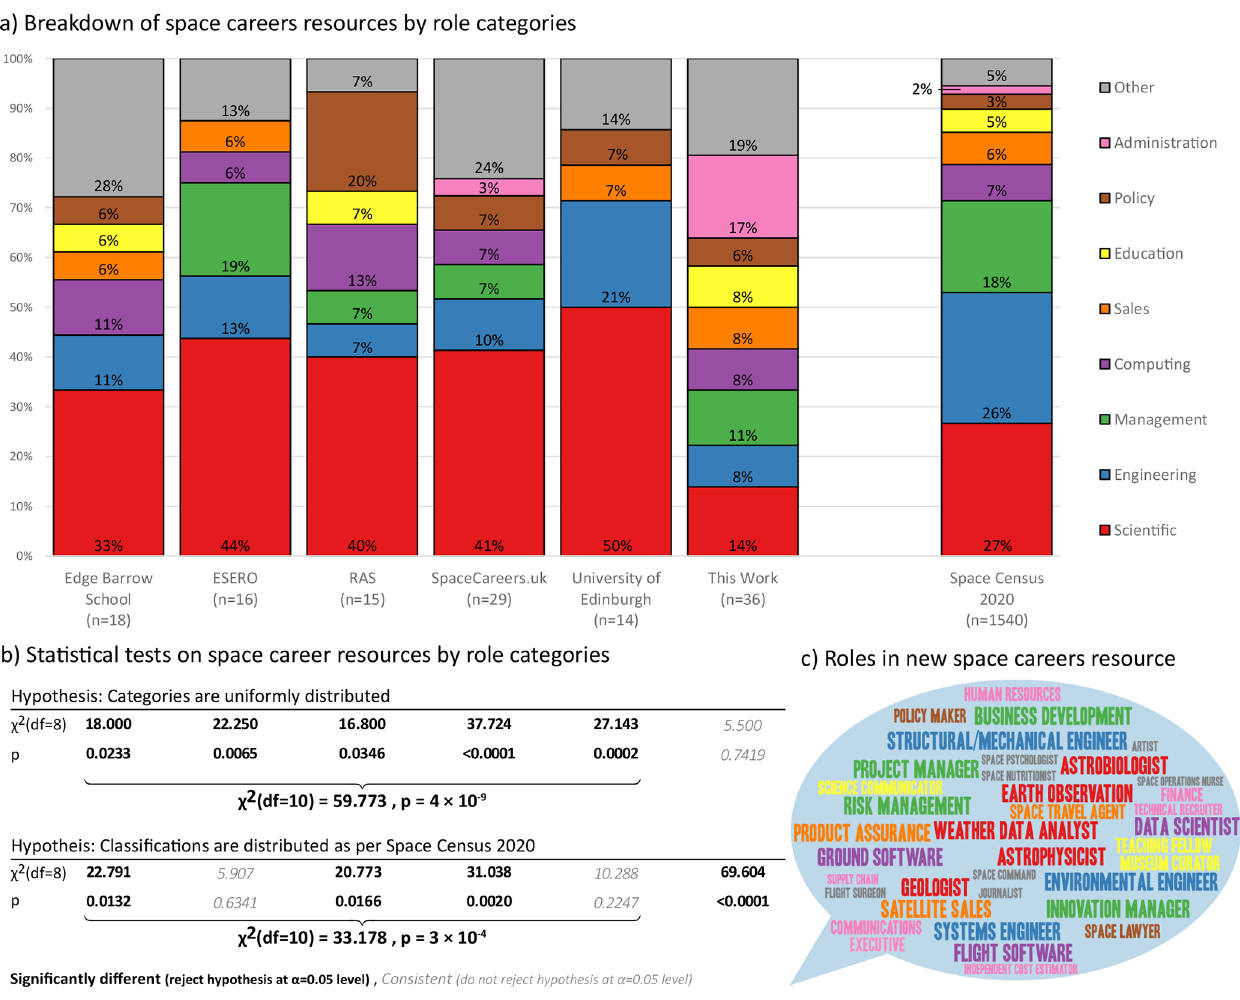
Figure 1. (a) Breakdown of current UK space sector careers resources compared to the UK Space Census 2020 (Thiemann and Dudley, 2021). (b) Outcomes of χ 2 statistical tests from these distributions. (c) Word cloud of the space roles chosen for a new resource, where colours relate to the categories in panel (a) (font sizes have no